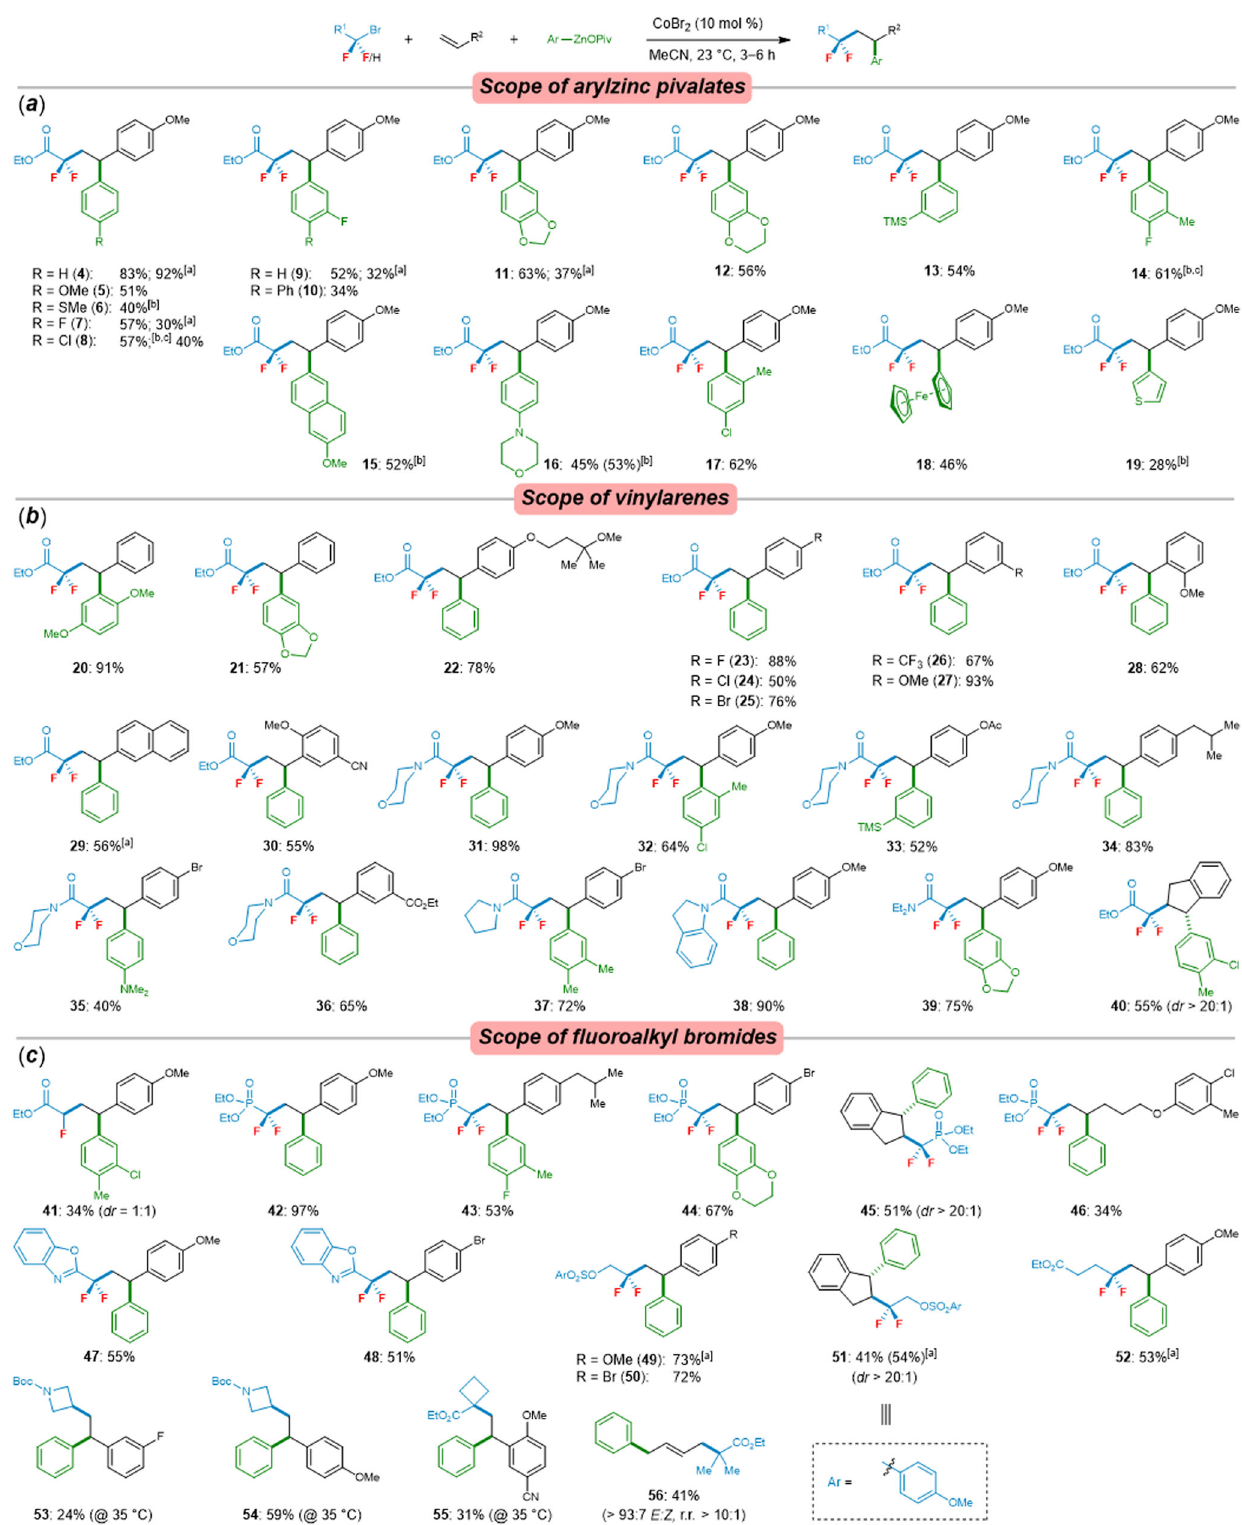
Fig. 3 Scope of cobalt-catalyzed cascade cross-coupling reaction. a Substrate scope of arylzinc pivalates. b Substrate scope of alkenylarenes and c fl uoroalkyl bromides. Reaction conditions: alkyl bromides (0.50 mmol, 2.0 equiv), alkenes (0.25 mmol, 1.0 equiv), arylzinc pivalates (0.50 mmol, 2.0 equiv), CoBr 2 (10 mol %), and MeCN (2.0 mL), 23 °C, 3 ‒ 6 h. [a] About 11 mol% of L5 was used. [b] CoBr 2 (20 mmol%) was used. [c] Ar 2 Zn ‧ 2Mg (OPiv)Cl (2.0 equiv) was